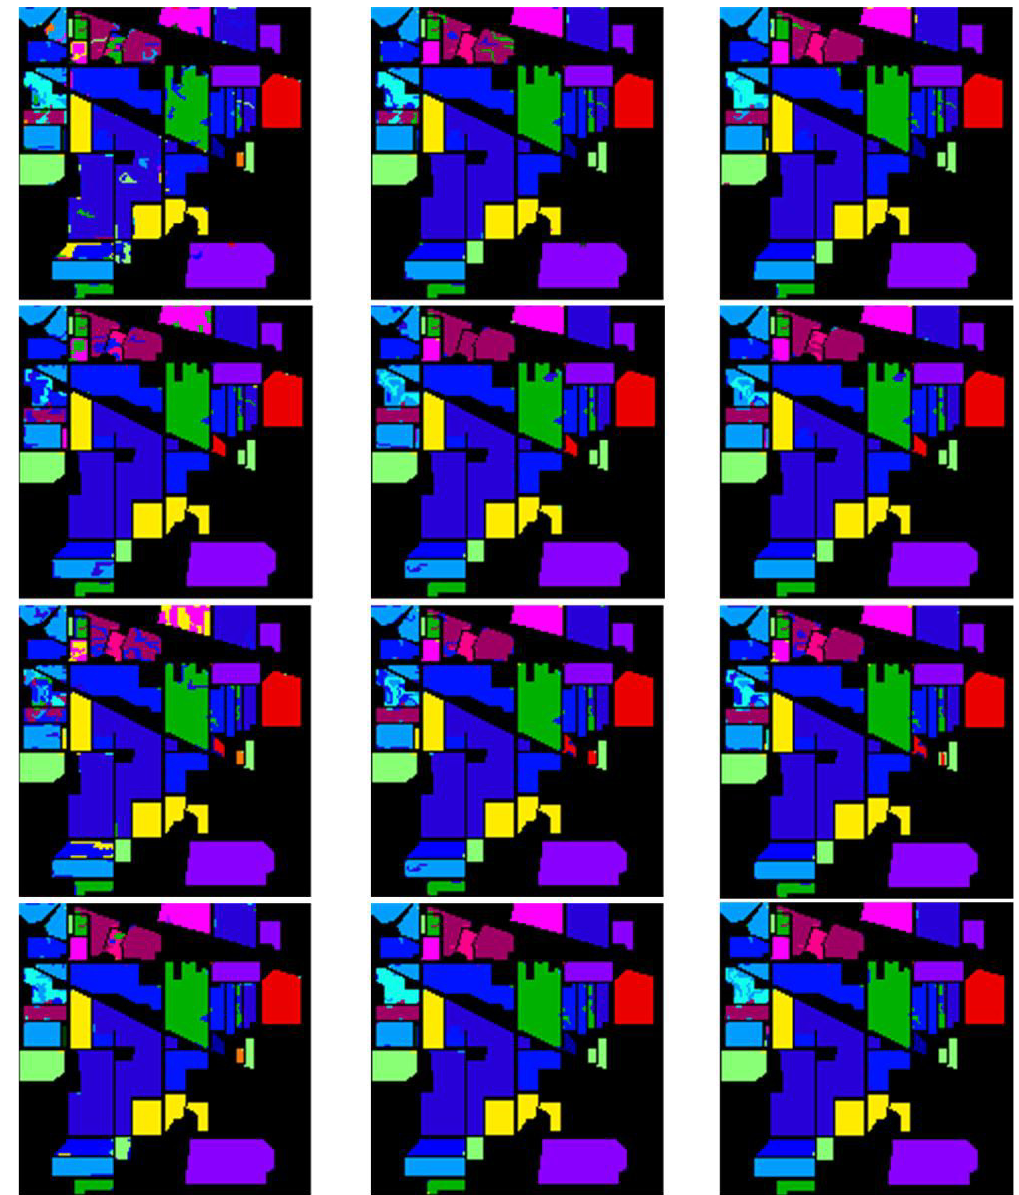
Figure 9. The classification maps of baselines and SALP over four classifiers on the Indian Pines dataset when ρ = 0.5. From the top row down to the last row: NN, SVM, RF, and ELM, from the first column to the last column: NLA, RLPA, and SALP. Please zoom in to see the